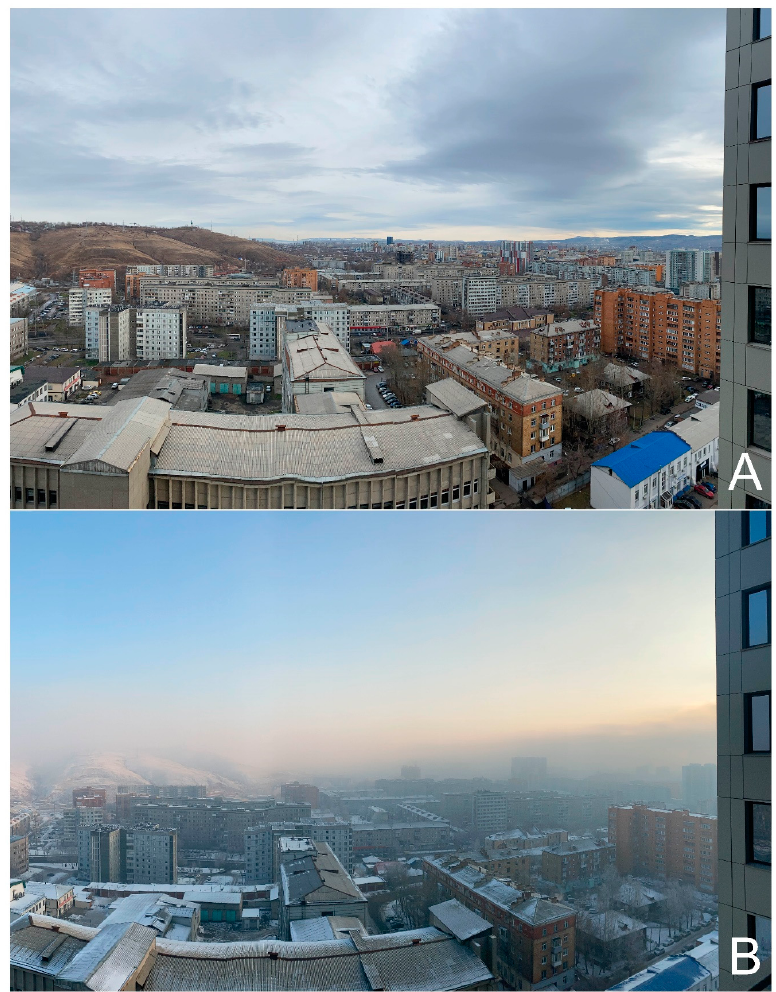
Figure 1. Krasnoyarsk city view from a high elevation point: ( A )—2 November 2020 (wind direction—SW, wind speed 2 m/s); ( B )—28 November 2020 (calm, air temperature − 14 Celsius, humidity—85%, atmospheric pressure 1040 mb, AQI from 175–638). Credit: A Romanov.